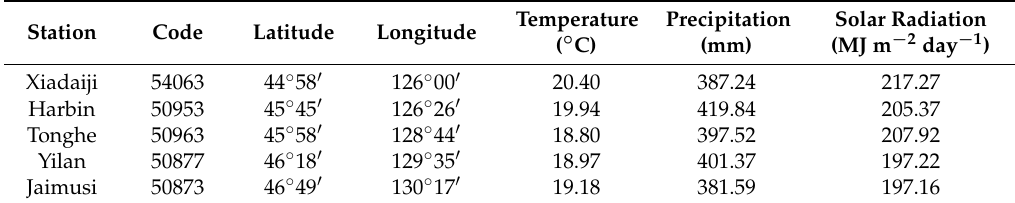
Table 1. The average air temperature, precipitation and solar radiation during the flood season at five meteorological stations in the study area from